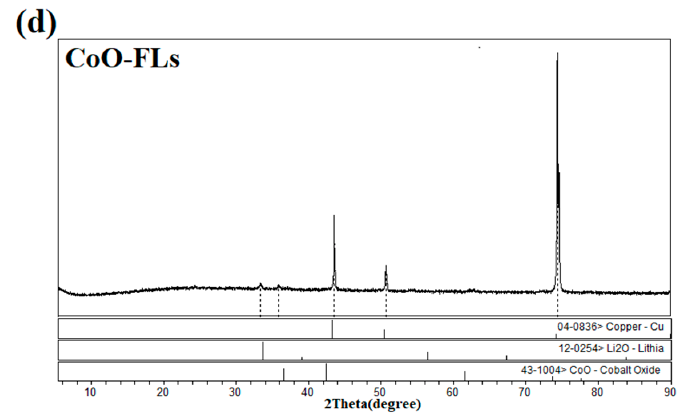
Figure 7. The morphologies and XRD pattern of CoO-NFs electrode ( a , c ) and CoO-FLs ( b , d ) after 80 cycles.